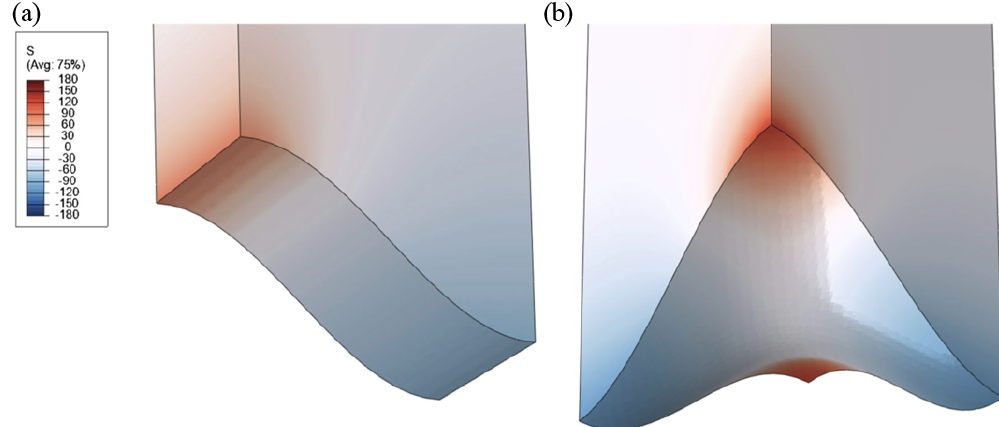
Fig. 25 σ 22 stress distribution in the TC layer under different 3D models cooled to room temperature: (a) grooved model and (b) sinusoidal model. Reproduced with permission from Ref. [134], © ASM International 2017.